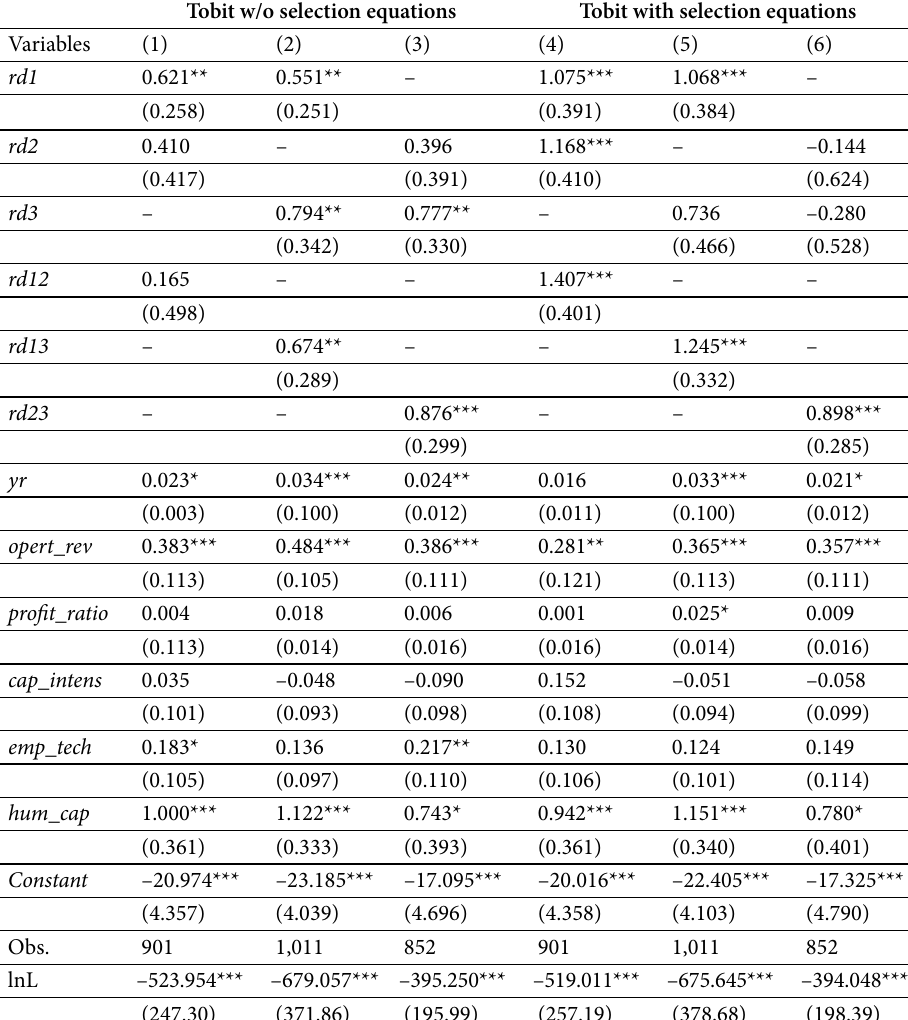
Table 5. Estimation results of innovation output (measured by marginal return to R&D investment) Tobit w/o selection equations Tobit with selection